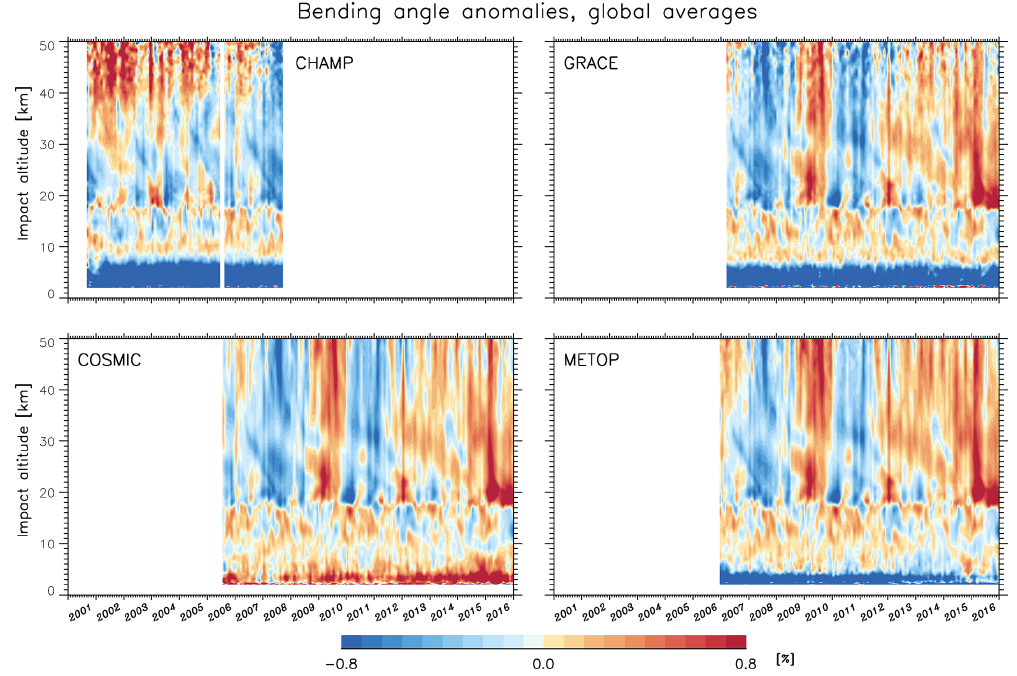
Figure 7. Global monthly mean bending angle anomalies, for the four RO missions included in the ROM SAF CDR v1.0. There is overlap between CHAMP and COSMIC from August 2006 to September 2008, between GRACE and COSMIC from March 2007 to December 2016, and between Metop and COSMIC from December 2006 to December 2016. Data are given on a 5 ◦ by 200m latitude–altitude grid and have been sampling-error corrected. The anomalies for the four satellite missions are computed based on the same reference climatology, obtained from RO